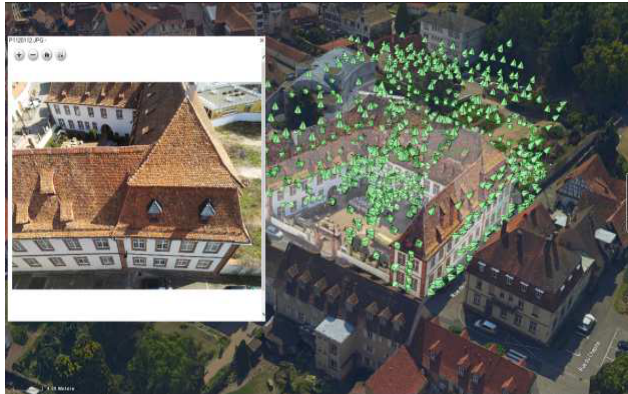
Figure5: Results of the image orientation process on the UAV data, performed on the Palais Stanislas in Wissembourg. The camera positions are displayed.